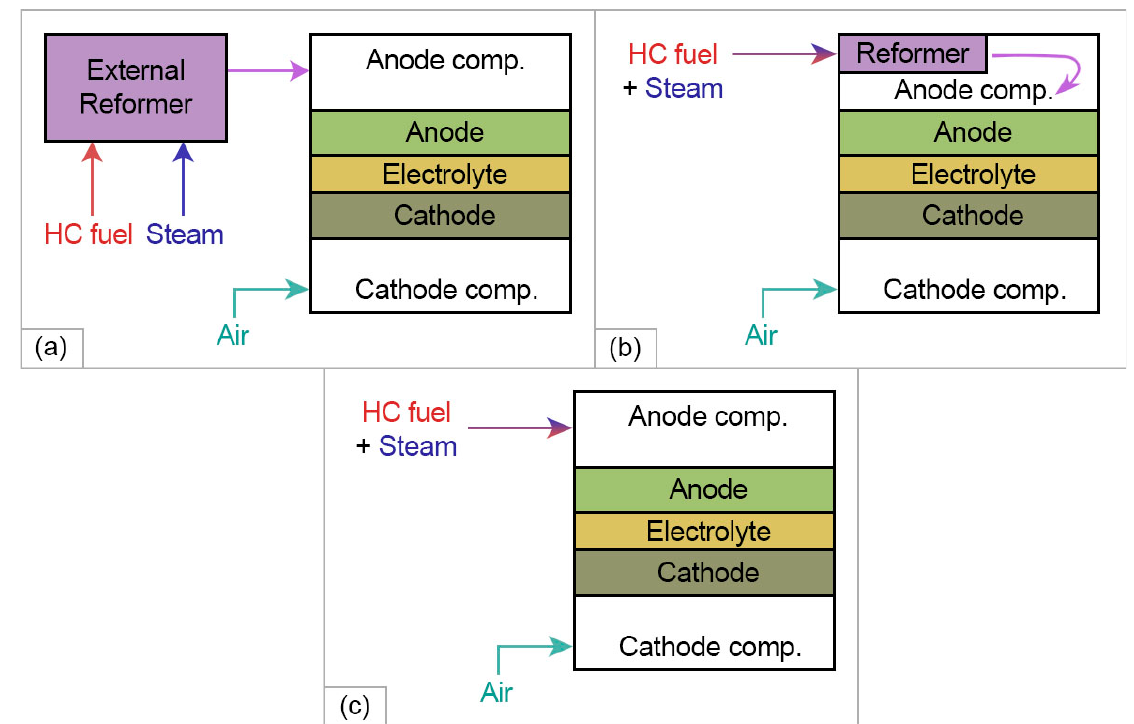
Figure 7. Schematic representation of ( a ) external reforming SOFC, ( b ) indirect internal reforming SOFC, and ( c ) direct internal reforming in SOFCs.